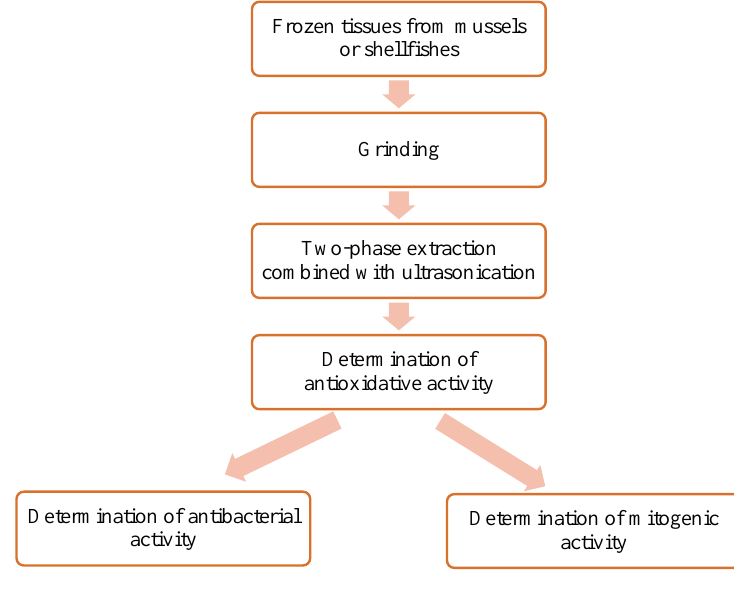
Figure 1 . The research methodology